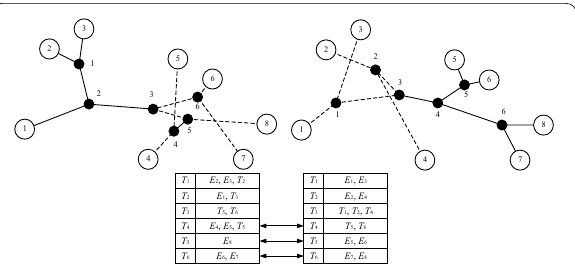
Figure 8 Crossover operation